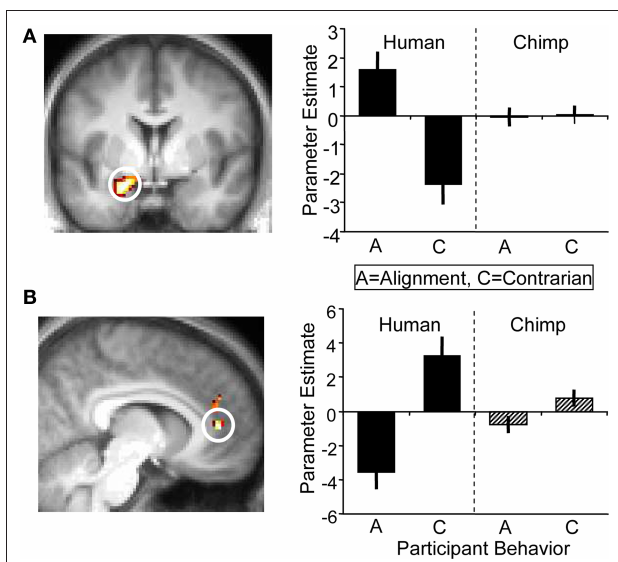
Figure 6 | BOLD responses at the time of decision. (A) (Left) Activation in left amygdala (peak at 18, 0, − 21; z = 3.5; p < 0.05) corresponding to an alignment decision. Alignment decisions were defined as choices that coincided with the social information of the present trial. (Right) Parameter estimates for left amygdala corresponding to alignment ‘A’ and contrarian ‘C’ decisions for human and chimp information. (B) (Left) Anterior cingulate cortex (peak at 0, 45, 15; z = 4.2; p < 0.005) was more active during contrarian decisions following human information, but showed no differential response to alignment/contrarian decisions following chimp information